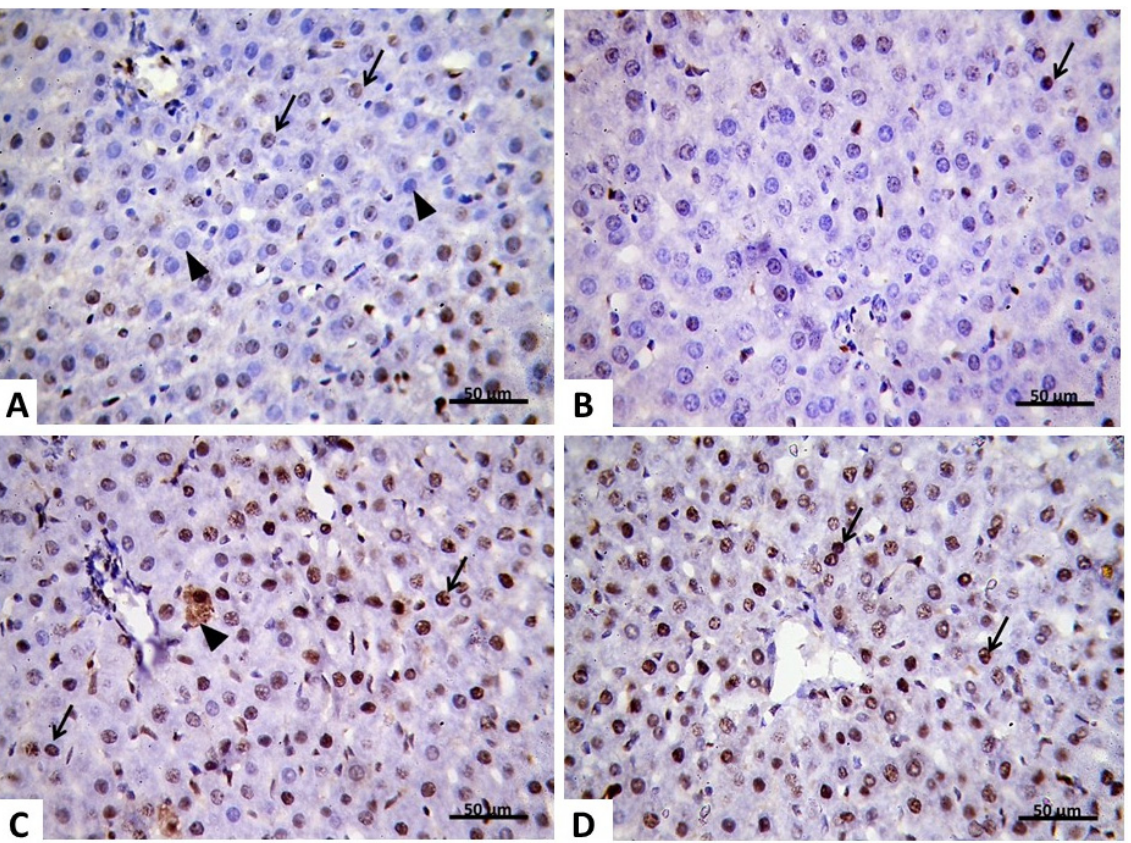
Figure 10. ( A ) Group I showing few hepatocytes with faint PCNA positive nuclei ( ↑ ). Notice the negative reaction of other nuclei ( ▲ ). ( B ) Group II PCNA ×400 avidin–biotin–peroxidase showing apparent fewer hepatocytes with PCNA positive nuclei ( ↑ ). Most hepatocytes show a negative reaction to their nuclei. ( C ) Group III PCNA ×400 avidin–biotin–peroxidase showing few hepatocytes with faint PCNA positive nuclei ( ↑ ). Notice the cytoplasmic reaction in some cells ( ▲ ). ( D ) Group nuclei ( ↑